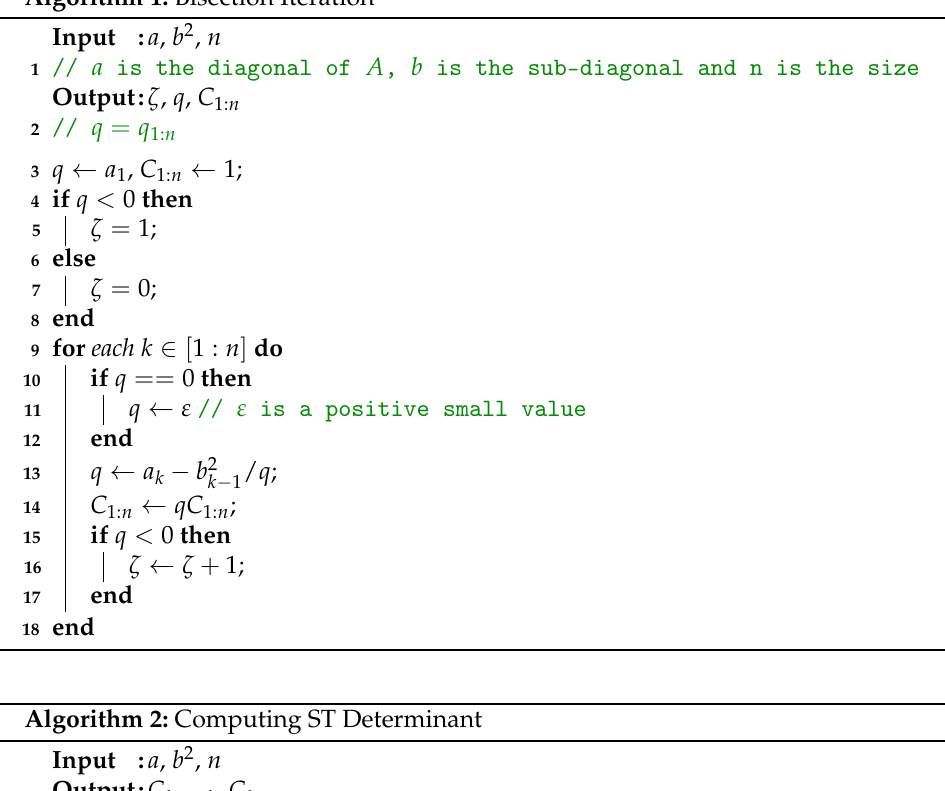
Algorithm 1: Bisection Iteration